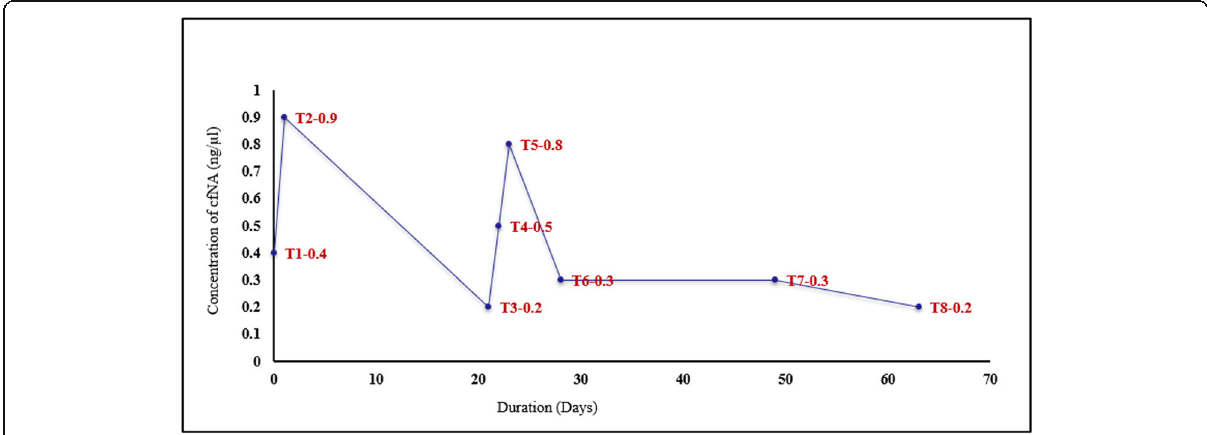
Fig. 4 Trend of concentration of cfNAs (ng/ μ l) at various time intervals in combined all four